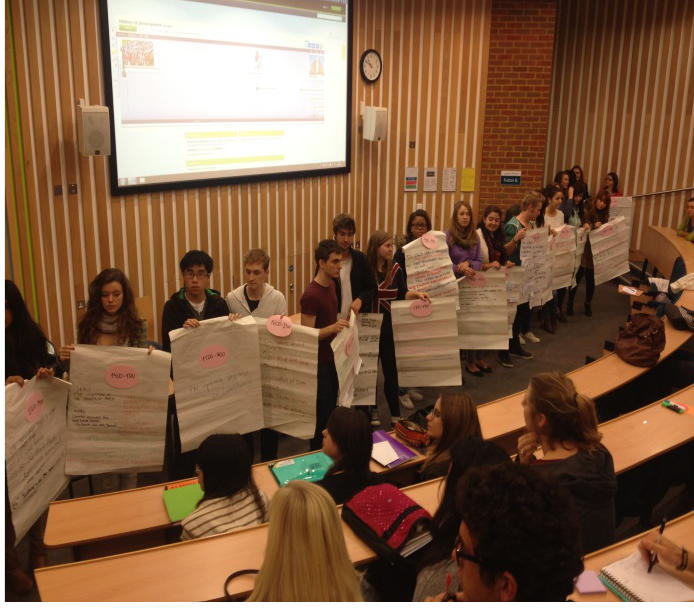
FIGURE 3 . MAKING A